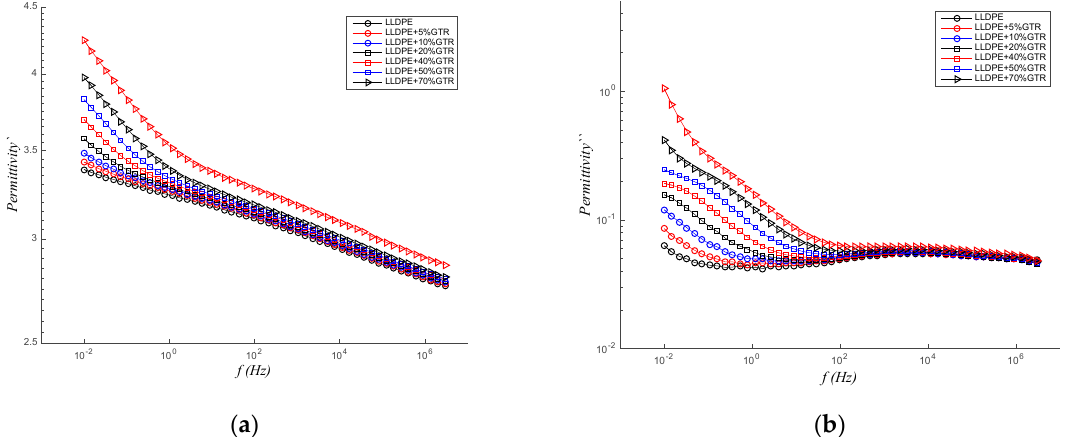
Figure 7. Real permittivity ( a ) and imaginary permittivity or dielectric loss factor ( b ) at various temperatures for the LLDPE/GTR-20% compound analyzed.